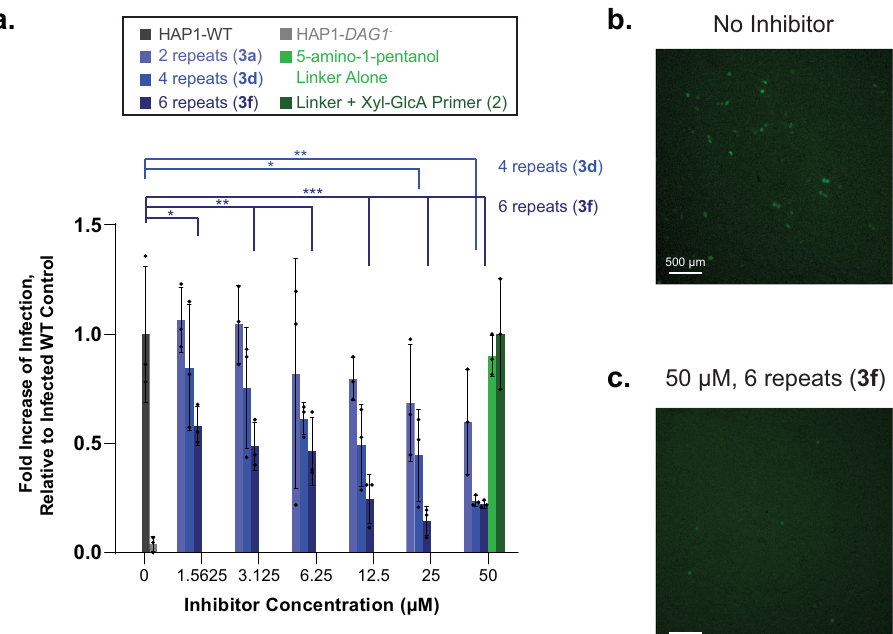
Fig. 6 Exogenous matriglycan inhibits LASV-pseudovirus infection of wildtype cells in a length and dose dependent manner. a HAP1-WT cells were infected with rVSV- Δ G-LASV (MOI 1) in the absence and presence of the indicated inhibitor compounds at various concentrations. Infectivity was assessed by fl uorescence microscopy by the number of eGFP-positive cells 6 h post infection. The 5-amino-1-pentanol linker compound and the linker compound conjugated to the Xyl-GlcA primer region (0 repeats) were unable to inhibit infection at the highest concentration tested. Measurements were taken at n = 3 independent experiments, where bars represent the mean and error bars represent SD. P -values are indicated as follows: P > 0.05, * P ≤ 0.05, ** P ≤ 0.01, *** P ≤ 0.001 (One-way ANOVA followed by Dunnett ’ s Test). b , c Representative fl uorescence microscopy images of infected WT cells with b no inhibitor or c 50 µ M inhibitor with 6 repeats. Scale bars represent 500 µ m. Compound identi fi ers are de fi ned in Fig. 2 and indicated in parentheses. Source data of a are provided as a Source Data fi